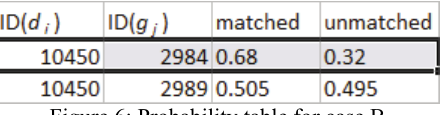
Figure 6: Probability table for case B